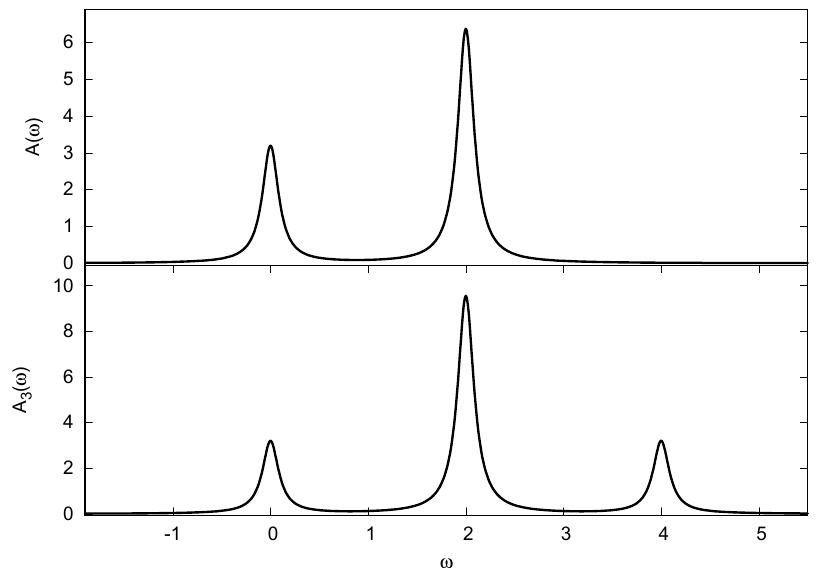
Figure 1: The addition part of the 1- and 3-body spectral function for the Hub- bard dimer at 1/4 filling in the non-interacting limit ( U = 0 ). Top panel: the exact spectral function A ( ω ) . Bottom panel: the exact three-body spectral func- ( ω ) . The peak at ω = 4 , which is present only in the three-body spectral tion A 3 function, is related to a satellite. The spectra correspond to ε